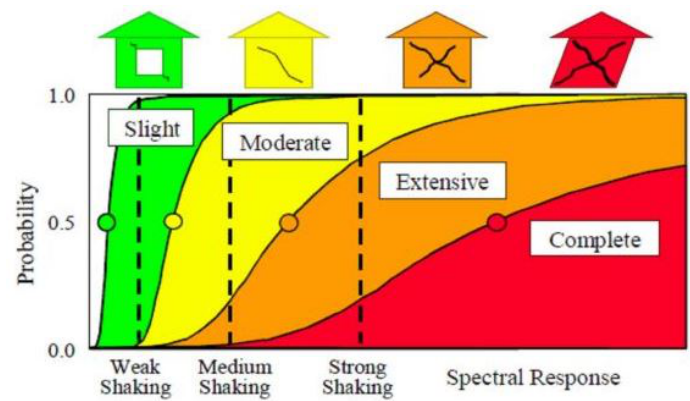
Figure 26. Example of a fragility functions, as reported in